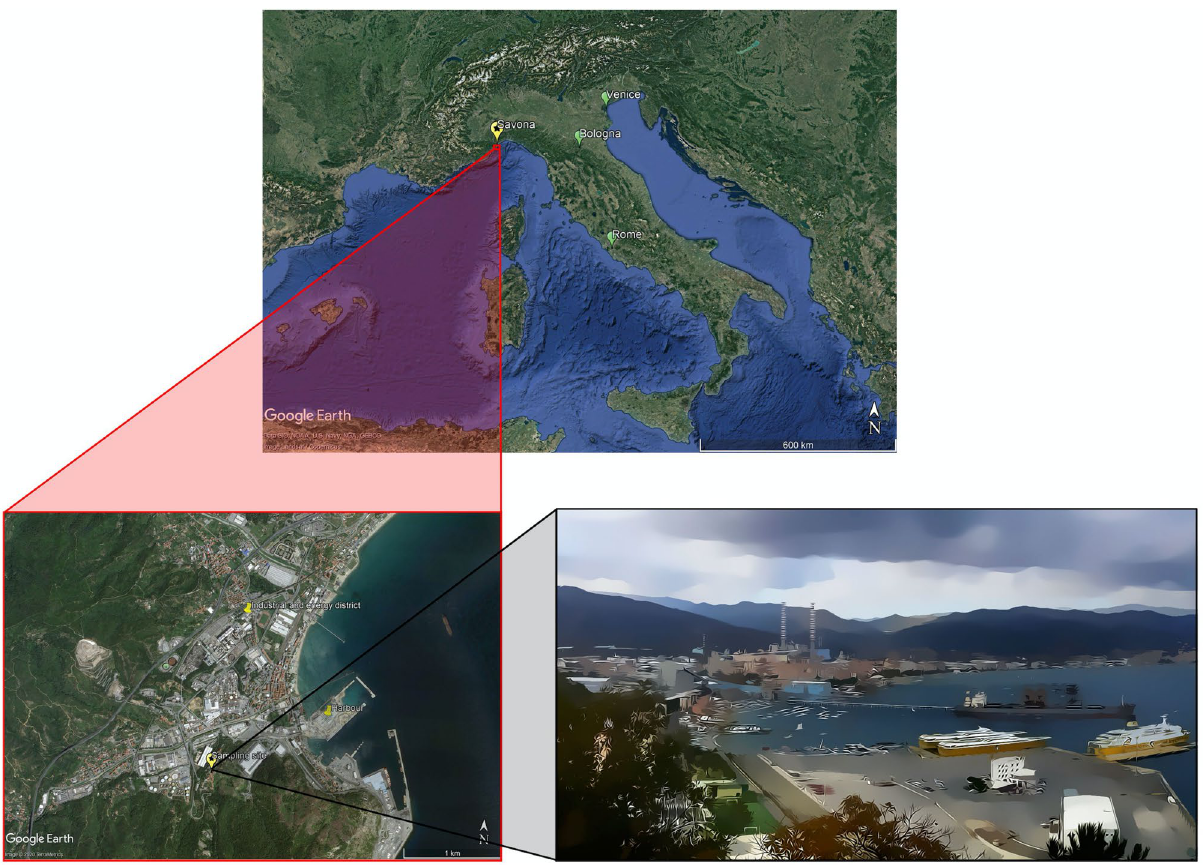
Figure 5. Location of the sampling site. Map providing the location of Savona in Italy (indicated with a yellow balloon with a star; other Italian cities are indicated with a green balloon) (top panel), and snapshot of the PM 10 sampling site with a 3D view of the surroundings (bottom panel) ( source: Google Earth; map data: SIO, NOAA, U.S. Navy, NGA, GEBCO, TerraMetrics). Adapted from the original file of P. Christener (https ://commo ns.wikim edia.org/wiki/File:Vado-Ligur e.jpg), CC BY-SA 3.0 (), via Wikimedia